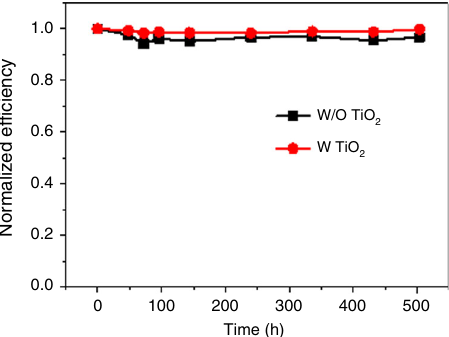
Fig. 7 Device stability. Stability of representative Sb 2 Se 3 solar cells without and with TiO 2 modi fi